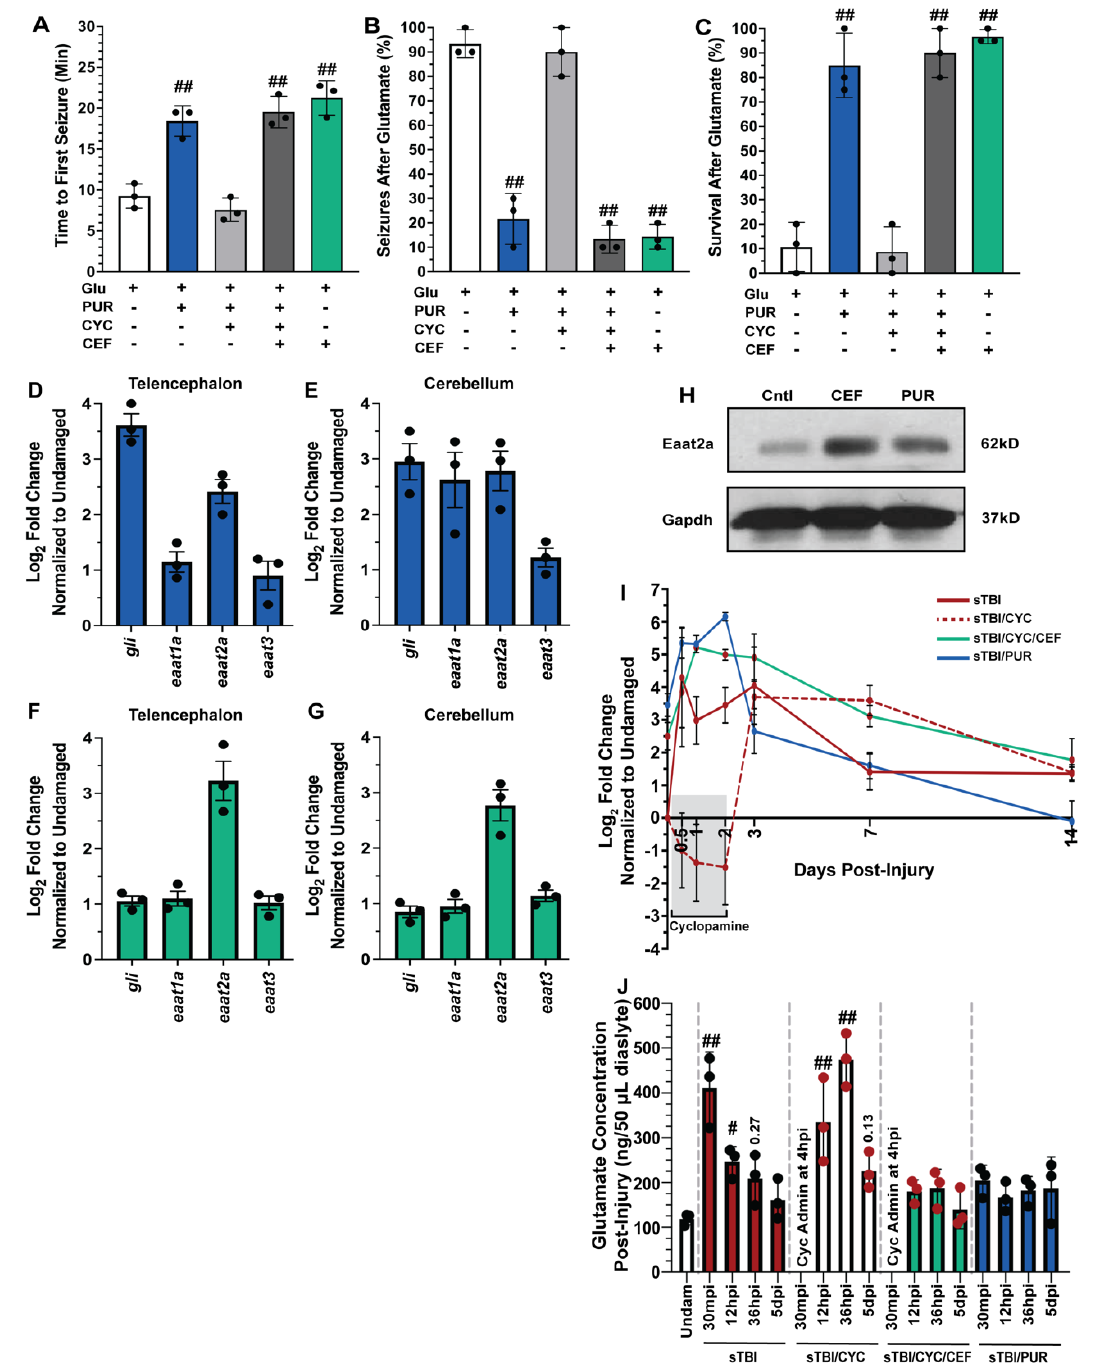
Figure 4. Shh activation combats excitotoxicity and upregulates Eaat2a. Undamaged fish with and without Shh modulation and ceftriaxone treatment were exposed to 5 mM glutamate in fish water ( n = 90 fish per control/experimental group). ( A ) Quantification of time to first seizure, ( B ) percent of the group to display at least 1 seizure event, and ( C ) percent of the group that survived for 1 h. ( D , E ) Expression of Shh component, gli, and excitatory amino acid transporter ( eaat ) genes by qRT-PCR revealed that purmorphamine increased gli and eaat2a mRNAs in both undamaged telencephalons and cerebellums ( n = 3 per control/experimental group, with 5 pooled telencephalons or cerebellums/trial). ( F , G ) Administration of ceftriaxone increased eaat2a mRNA expression levels without Shh activation in undamaged telencephalons and cerebellums ( n = 3 per control/experimental group, with 5 pooled telencephalons or cerebellums/trial). ( H ) Expression of Eaat2a in the undamaged cerebellum (5 pooled cerebellums per control/experimental group) following either purmorphamine or ceftriaxone treatment was assessed by immunoblot, using GAPDH as a loading control